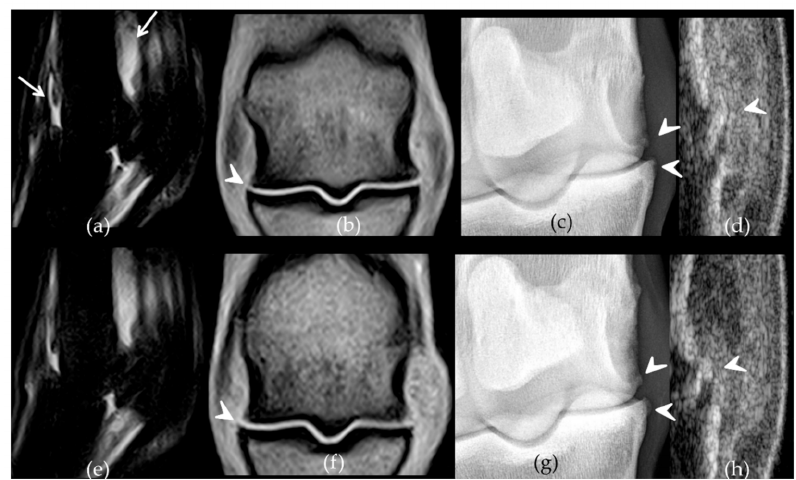
Figure 5. Comparative imaging findings observed on week 12 on the front metacarpophalangeal joints of horse 4. The left fore fetlock ( a – d ) received placebo treatment while the right fore fetlock ( e – h ) received umbilical cord blood derived mesenchymal stem cells (UCB-MSCs)on week 3. On the left fetlock there was grade 3 (white arrows) synovial effusion ( a ) and periarticular osteophytes ( b ) (arrow heads) on Short Tau Inversion Recovery sagittal magnetic resonance imaging (MRI) images ( a ) and T1-weighed dorsal MRI images ( b ) respectively, while grades 2 were observed on the right fetlock ( e – f ). There are grade 2 (arrow heads) osteophytes on the dorsomedial-palmarolateral 35 ◦ oblique radiographic views from both fore fetlocks ( c , g ) and on the dorso-lateral aspect of both joints on ultrasound ( d , h ) (arrow heads).